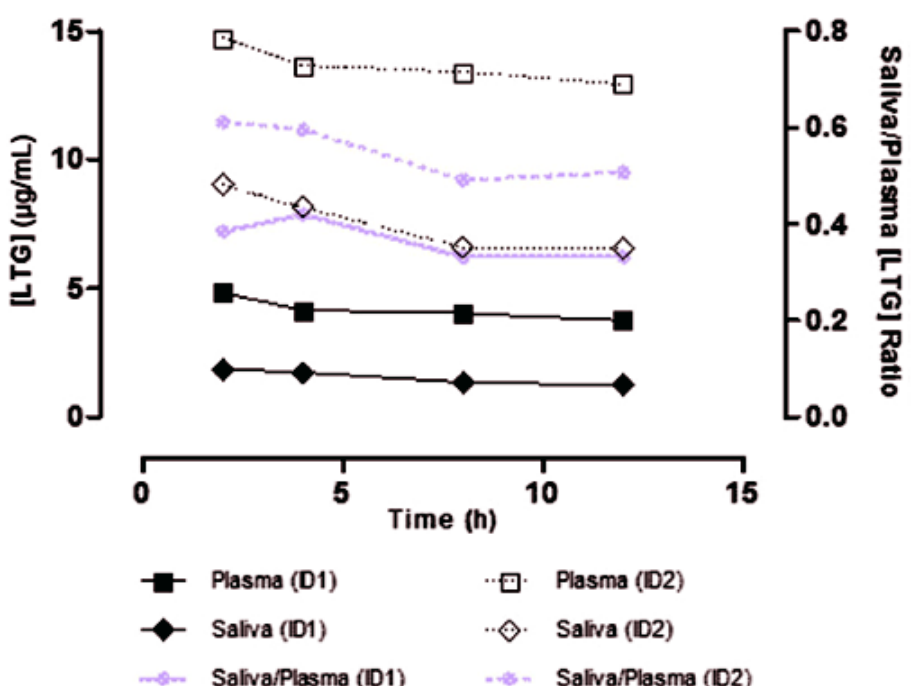
Figure 12. Concentration–time profiles of lamotrigine (LTG) obtained from plasma and saliva samples collected at 2, 4, 8, and 12 h post-dose (taking as reference the morning dose) in two patients (ID1 and ID2) under oral LTG therapy (ID1, 100 mg once-daily in the morning; ID2, 150 mg in the morning, and 200 mg at night in cotherapy with valproic acid). The corresponding salivary to plasma LTG concentration ratios were also calculated at 2, 4, 8, and 12 h post-dose and graphically represented for both patients [131].